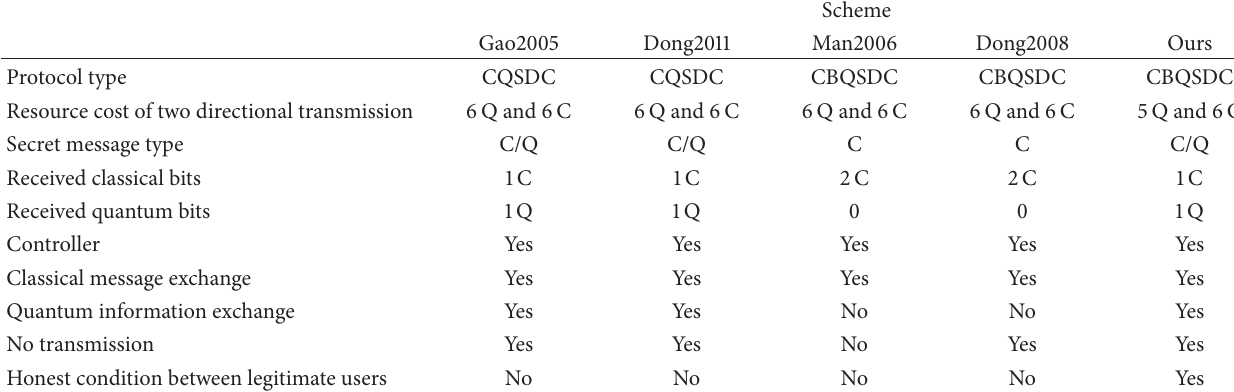
Table 1: Comparison of CQSDC and CBQSDC protocols with our